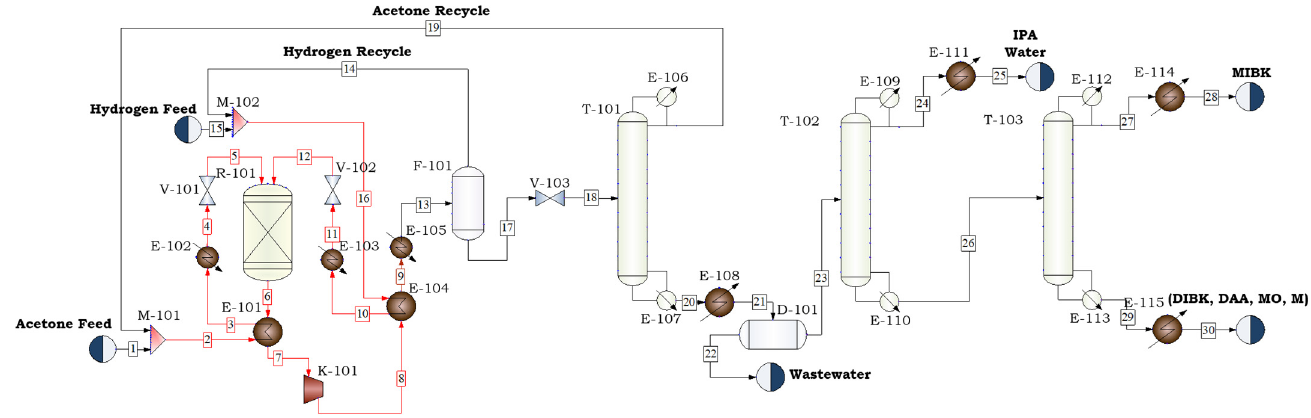
Figure 4. Developed process flow diagram (PFD) of the MIBK process after heat integration. Table 2. Material balance of key streams for the developed MIBK process.